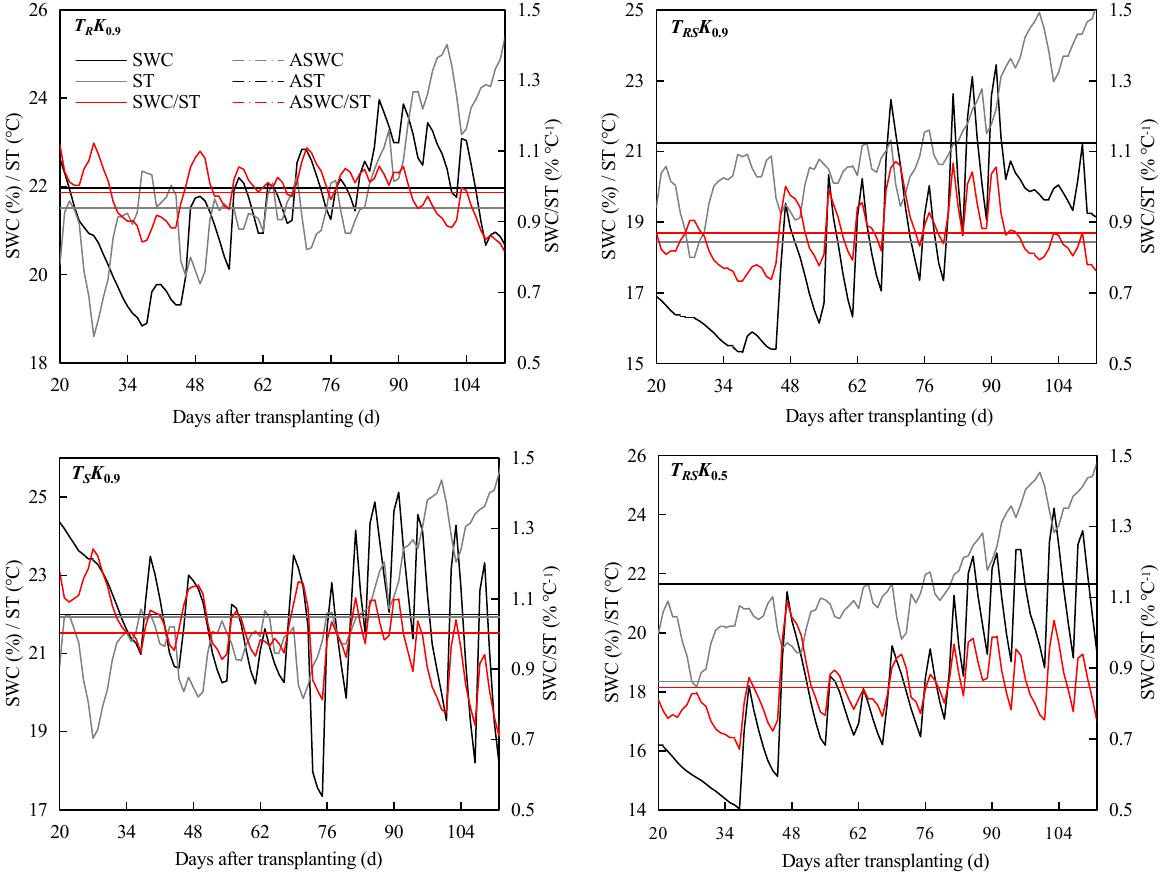
Figure 3. Change curves of soil temperature (ST), soil water content (SWC) and ratio of soil water content to temperature (SWC/ST) in 2021. ASWC is the average soil water content, AST is the average soil temperature in the 0–20 cm soil layer and ASWC/ST is the average soil water-heat ratio.